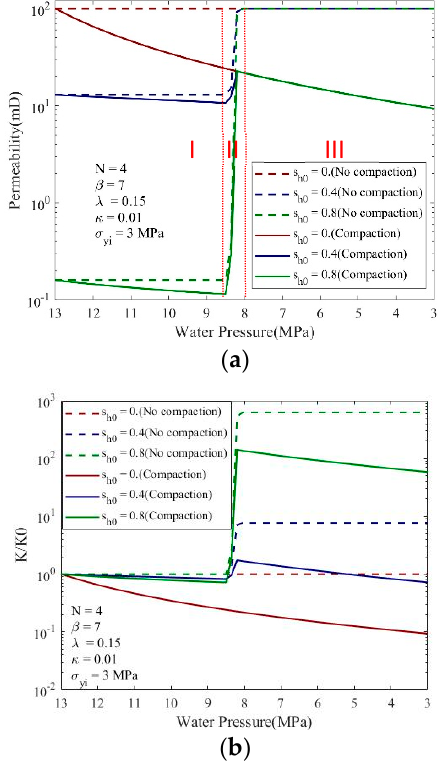
Figure 5. Variation of ( a ) effective permeability and ( b ) permeability ratio of HBSs with depressurization corresponding to different initial hydrate saturations.